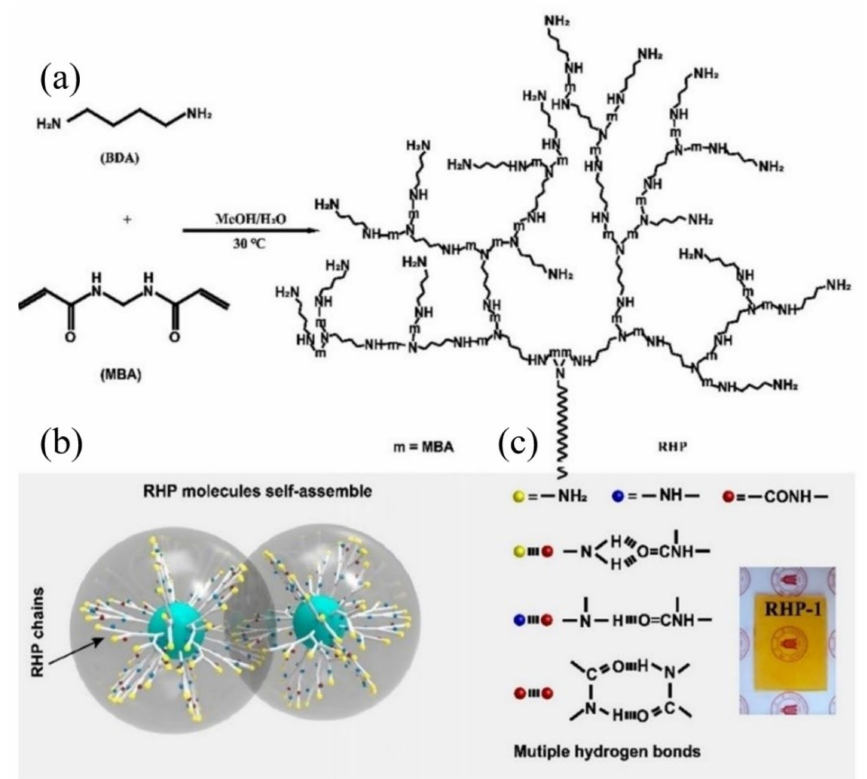
Figure 4. Design concept and synthesis of RHP. ( a ) Chemical route to the synthesis of RHP through Michael addition between MBA and BDA at 30 ◦ C. ( b ) Schematic diagram of interactions between RHP molecules. ( c ) Multiple hydrogen bonds of RHP molecules. (Inset) A photograph of RHP-1. Reproduced with permission from [96]. Copyright 2020 National Academy of